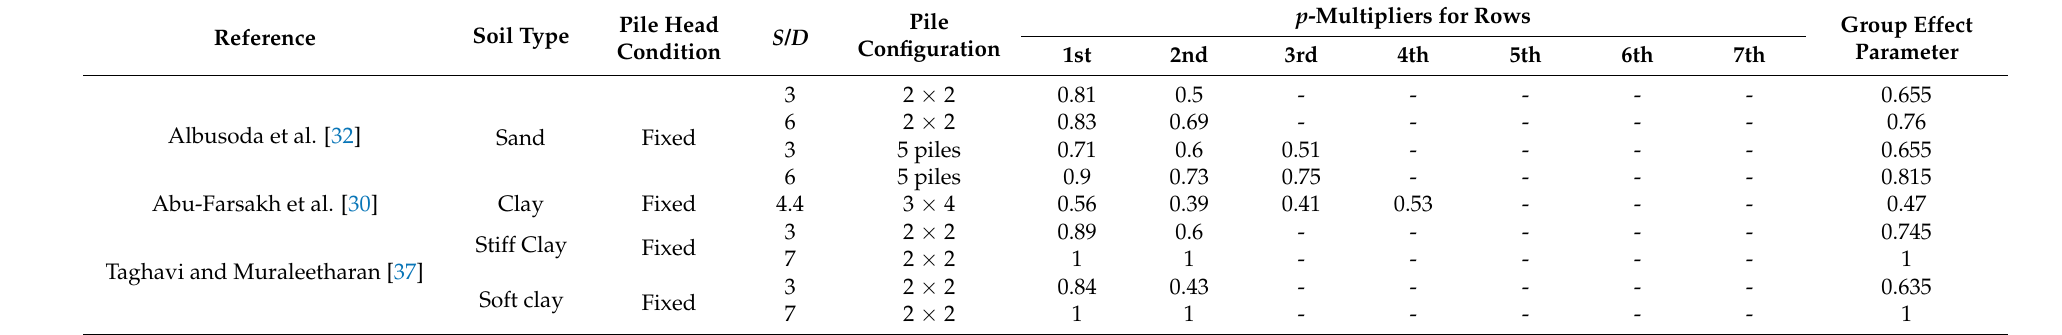
Table 3. Numerically derived p -multipliers in previous